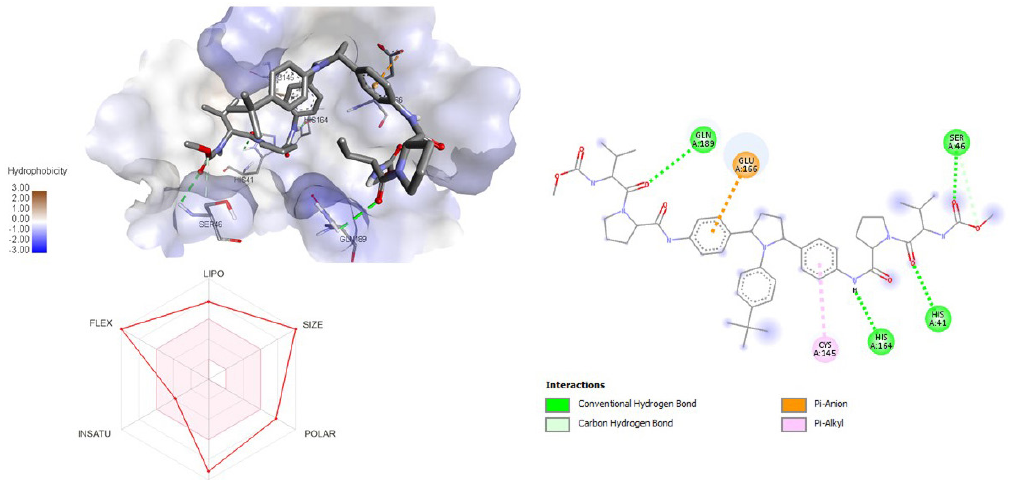
Figure 9. 3D and 2D interaction of ligand ombitasvir with SARS-CoV-2 protein (PDB ID: 7P35) along with in silico ADMET